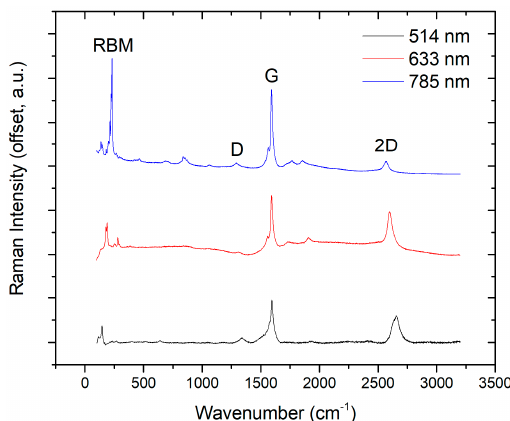
Figure 4. Representative normalized Raman spectra excited at (blue line) 785 nm, (red line) 633 nm, and (black line) 514 nm, of raw carbon soot grown on kaolin sized paper chosen at random. The presence of D, G, and 2D peaks confirm the presence of graphitic carbon in the form of carbon nanotubes, in addition to other forms of carbon. Table 1. Resonant Raman peak intensities for the raw carbon soot grown on kaolin sized paper.